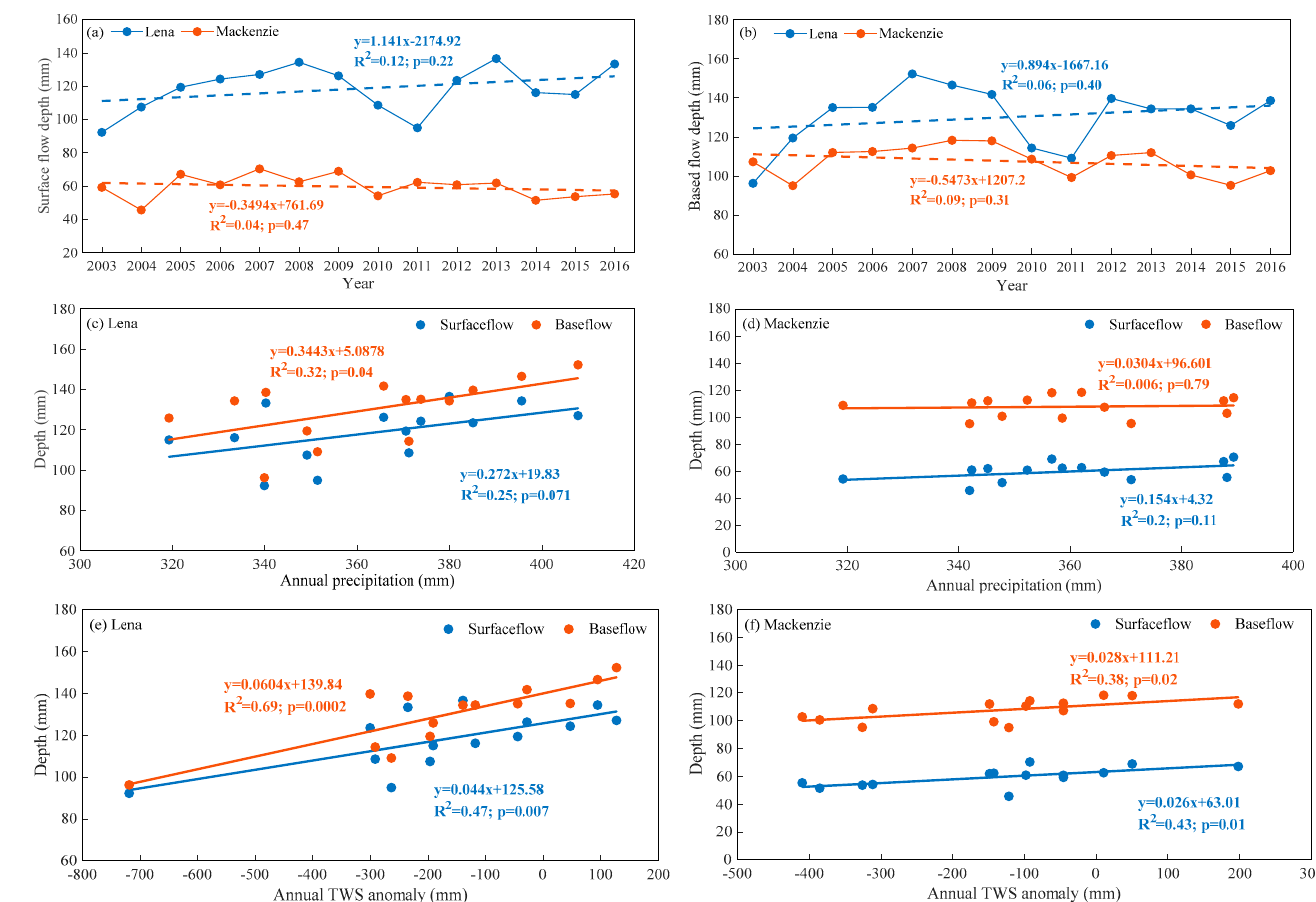
Figure 6. Annual changes in the surface flow and base flow ( a , b ), and relationships between the annual runoff and annual precipitation and TWS ( c – f ) in the MRB and LRB during 2003–2016.